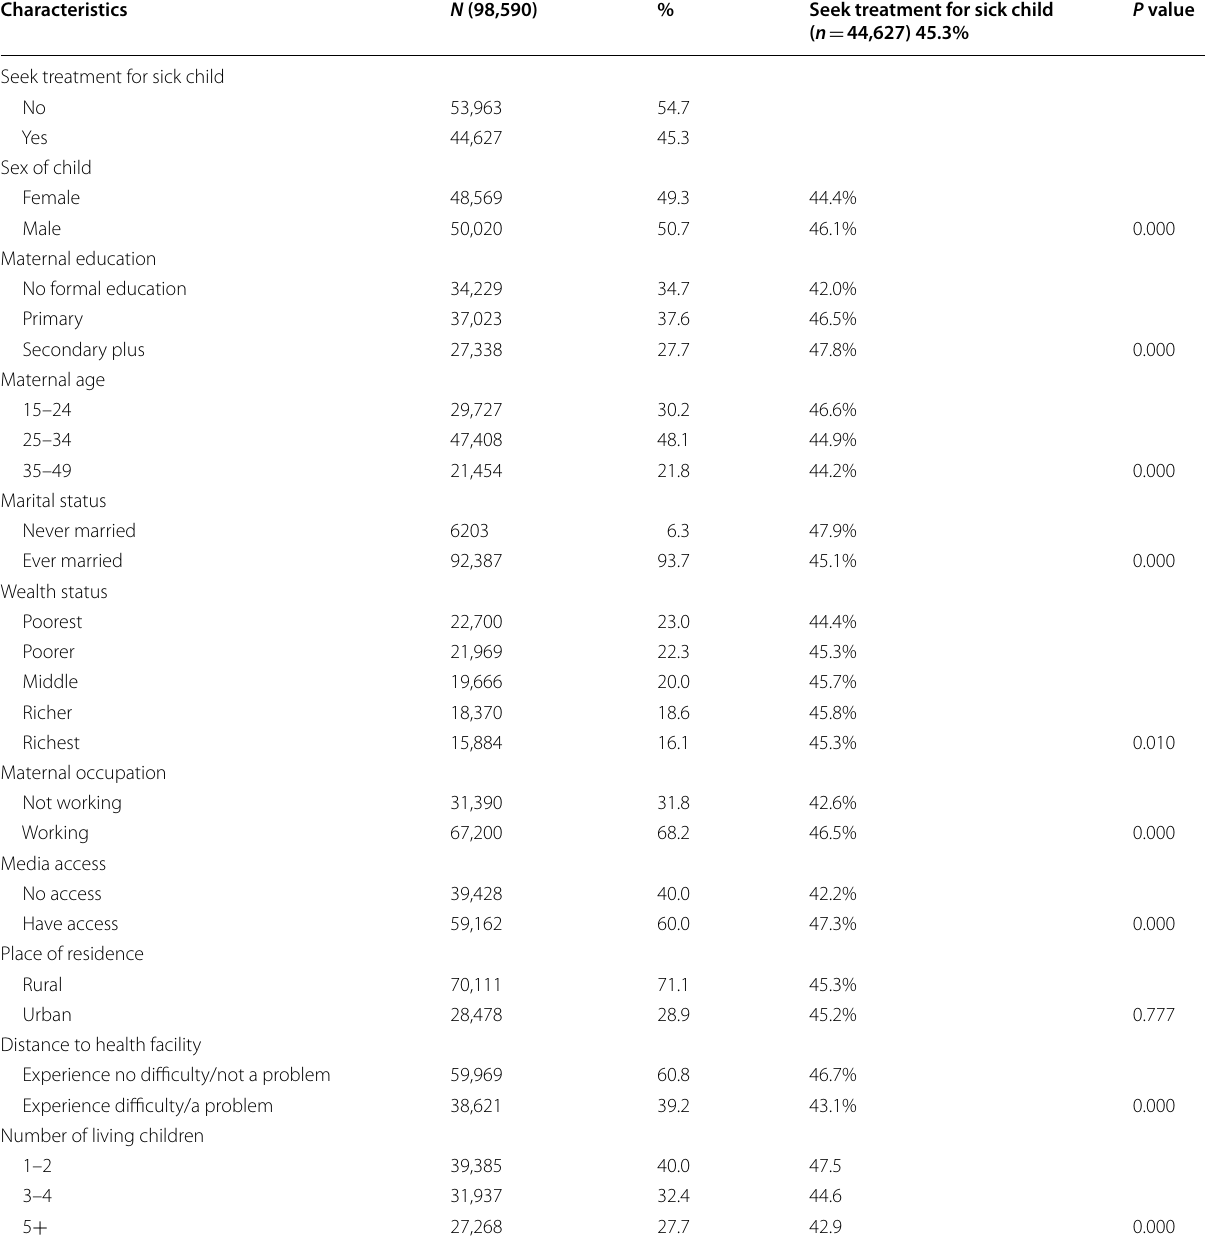
Table 2 Socio-demographic profile and prevalence of health care seeking behaviour for children with childhood illnesses Characteristics N